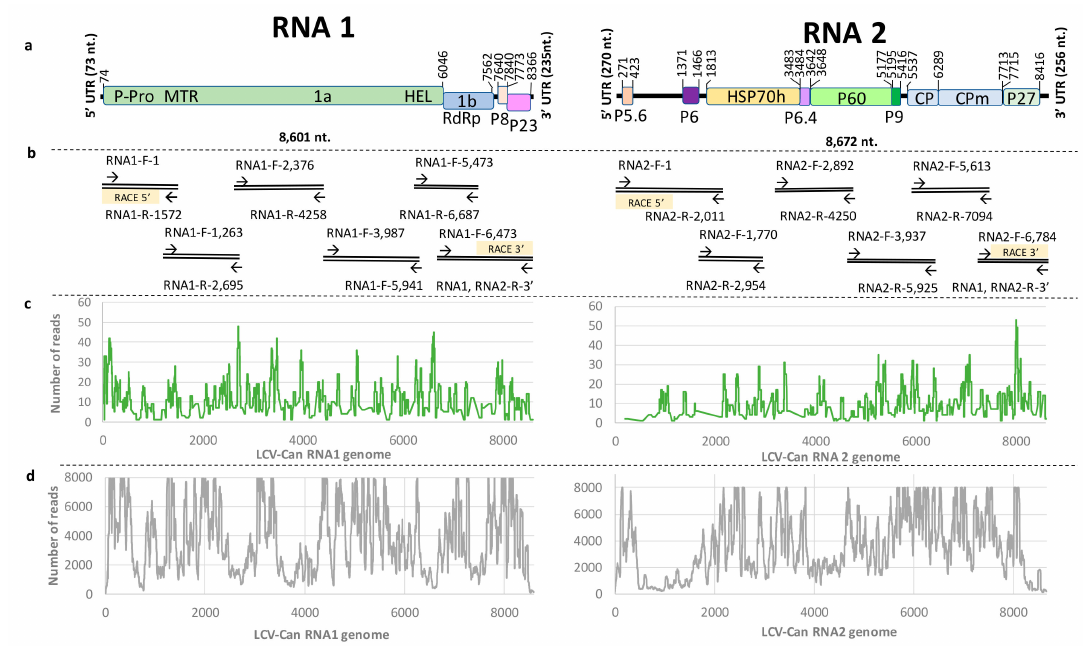
Figure 2. Genome organization of cannabis lettuce chlorosis virus (LCV) isolate. ( a ) A scheme of the cannabis LCV isolate RNA1 and RNA2 segments encoding putative viral proteins represented in rectangles. ( b ) RT-PCR primers that established the full genome sequence of the cannabis LCV isolate (Table S2). ( c ) Obtained reads and coverage of cannabis LCV isolate by NGS Illumina Miseq sequencing of small RNA preparation. ( d ) Obtained reads and coverage of cannabis LCV isolate by NGS Illumina Hiseq sequencing of total RNA